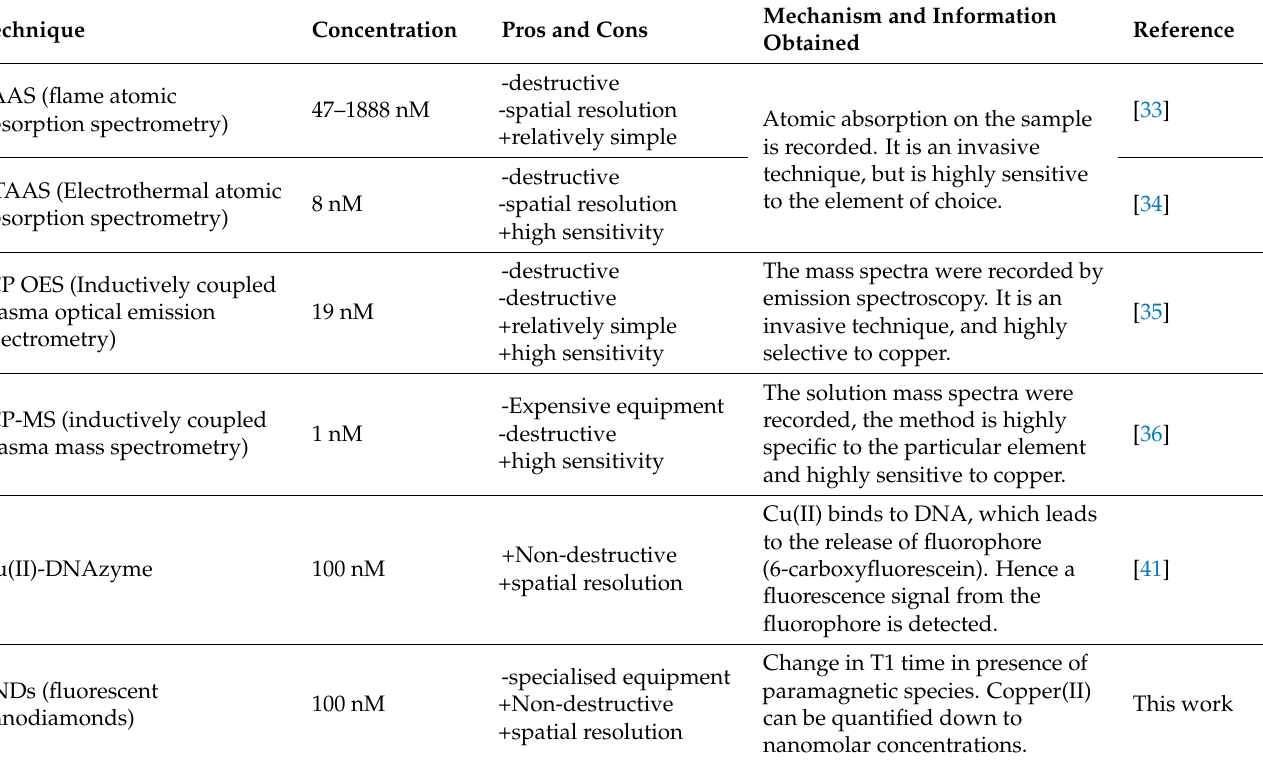
Table 1. Comparing sensing performance of different